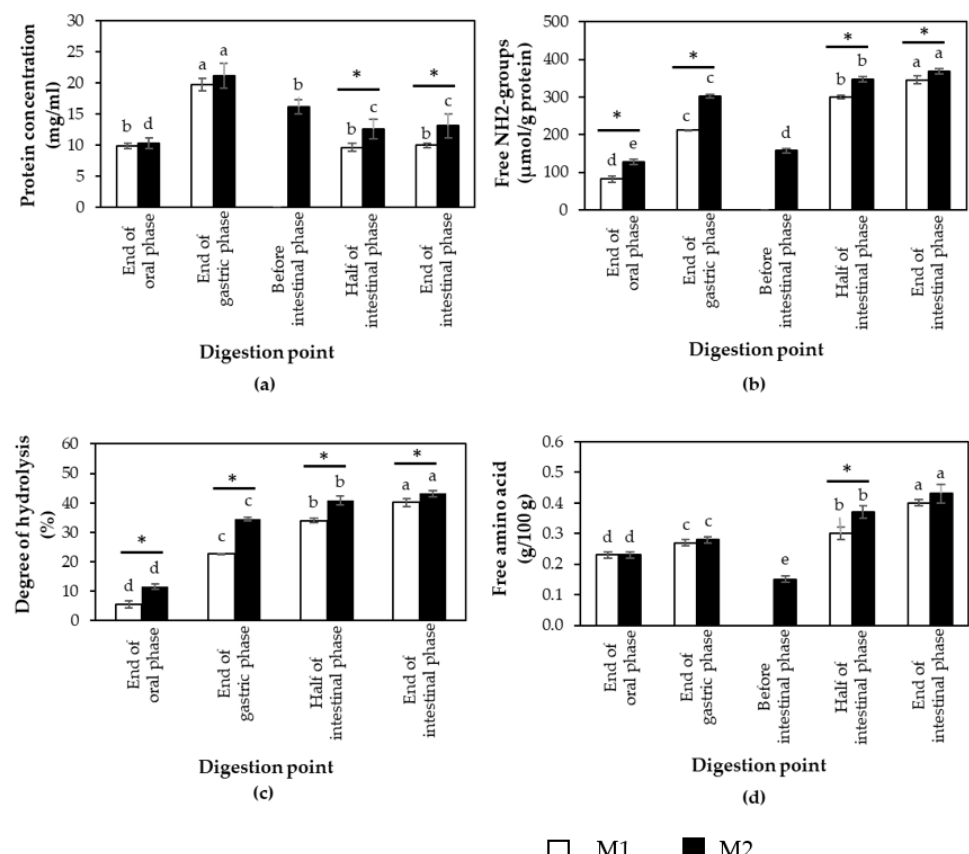
Figure 2. ( a ) Protein concentration; ( b ) free NH 2 -groups; ( c ) degree of hydrolysis (%); ( d ) free amino acid contents of commercial broiler breasts digested by method 1 (M1) and method 2 (M2) and collected at end of oral phase, end of gastric phase, and before, half, and end of intestinal phase. Bars and error bars represent mean and standard deviation ( n = 4), respectively. Asterisks above bars indicate a significant difference between the in vitro methods at particular phase ( p < 0.05). Different letters indicate significant difference among different digestion points ( p < 0.05).